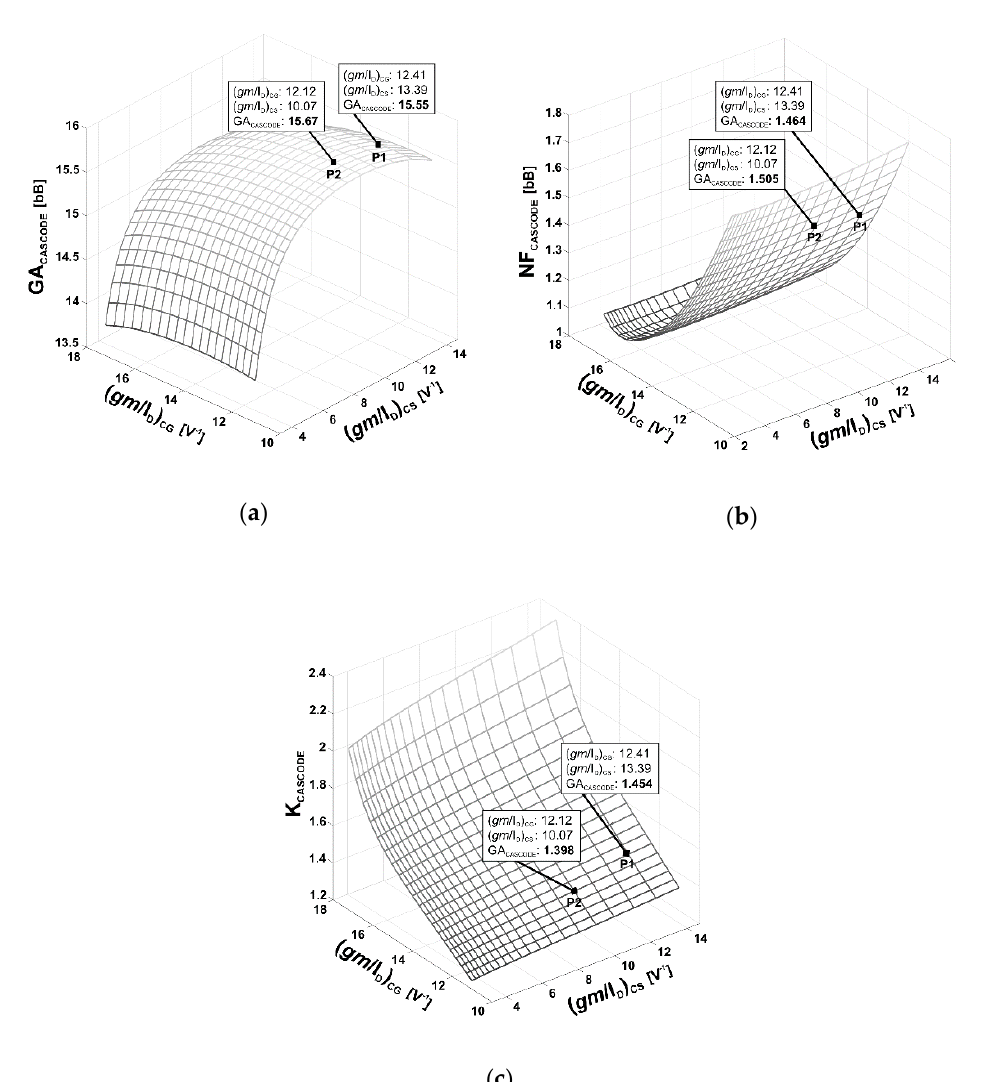
( gm / I D ) CS and ( gm / I D ) CG : ( a ) gain; ( b ) noise figure; ( c ) stability factor K Figure 13. Plot of the cascode stage response for the maximum gain condition, as a function of the ( gm/I D ) CS and ( gm/I D ) CG : ( a ) gain; ( b ) noise figure; ( c ) stability factor K .